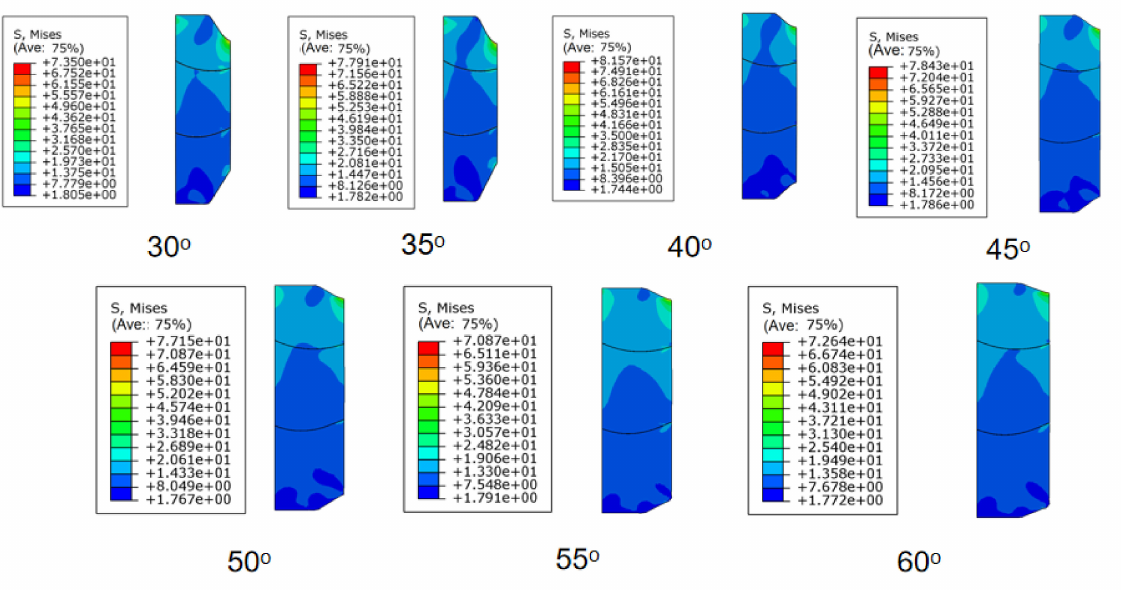
Figure 11. Equivalent stress nephogram of rubber packing element with different inclusion angles under 100 T setting-down